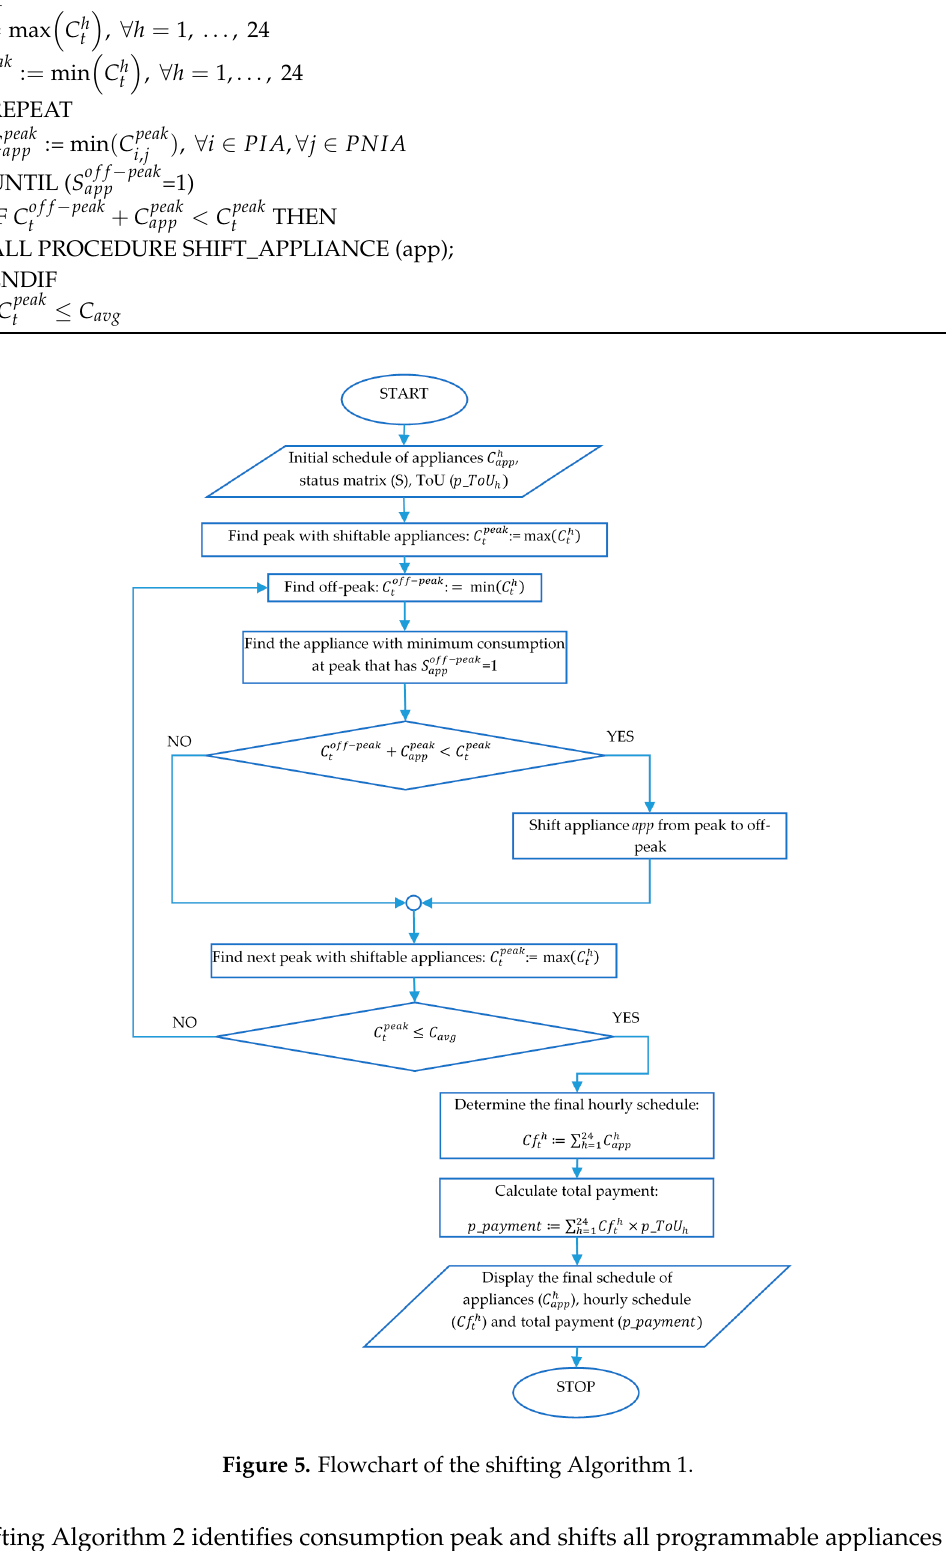
Algorithm 2 Gradual-shifting off-peak algorithm